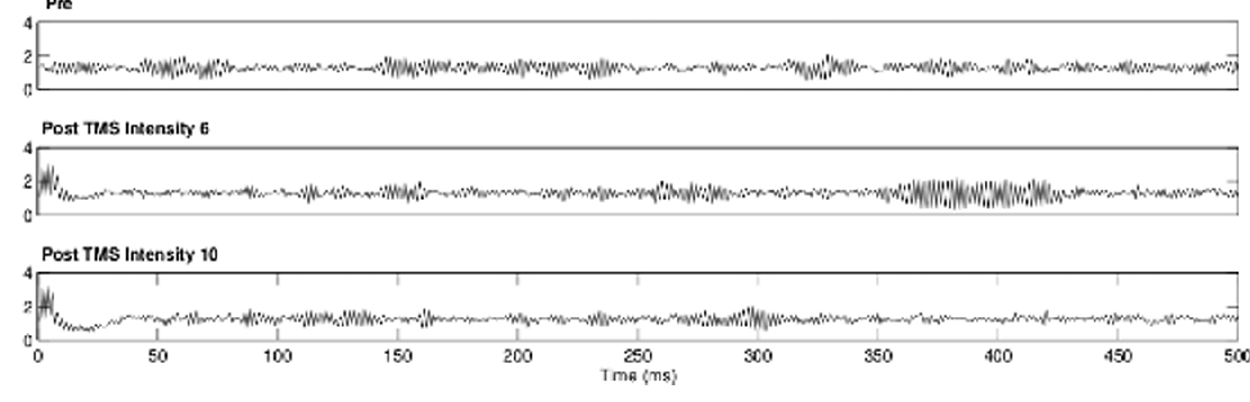
Figure 4. Typical time course of the output function r (t) of the neural network 500 ms before the stimulation (PRE) and 500 ms after the last TMS pulse (POST) for the two intensities TMS-INTENSITY 6 and TMS-INTENSITY 10.